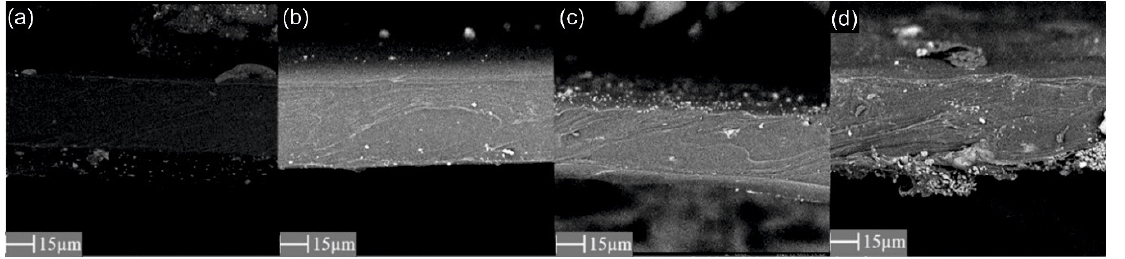
Figure 6. SEM image of membrane cross section with POSS-Ph added; ( a ) PEBAX 2533 + 0 wt% POSS-Ph, ( b ) PEBAX 2533 + 0.75 wt% POSS-Ph, ( c ) PEBAX 2533 + 2 wt% POSS-Ph, ( d ) PEBAX 2533 + 8 wt% POSS-Ph.